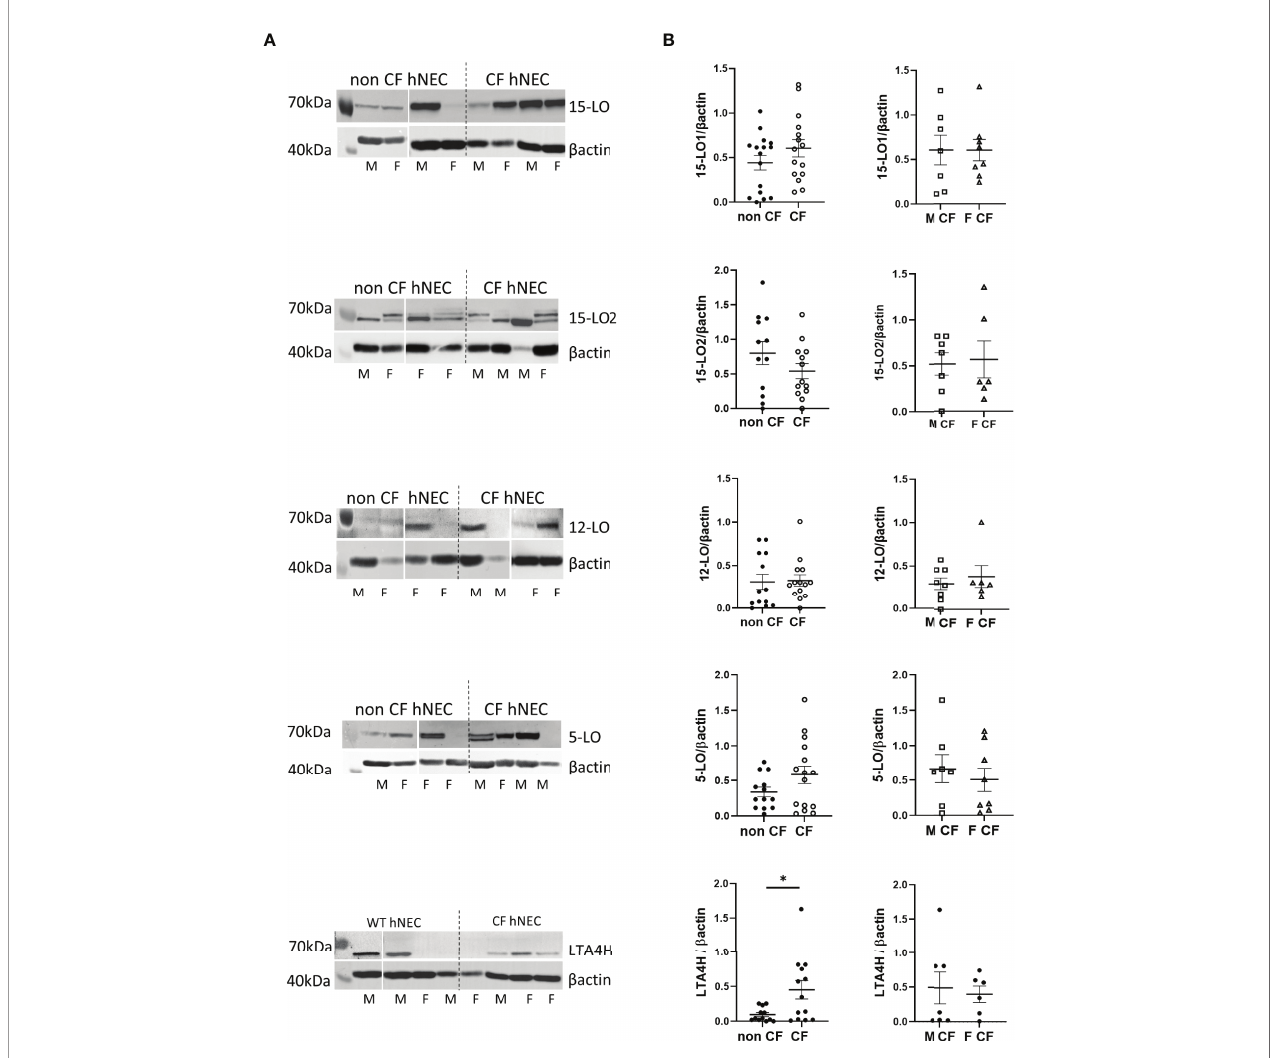
FIGURE 6 | Expression levels of the 15-LO1, 15-LO2, 12-LO, 5-LO and LTA4H in hNEC. (A) Typical western-blotting results from protein extract of non-CF and CF female (F) and male (M) hNEC. (B) Comparison of the mean enzymes expression levels between non-CF and CF hNEC (left) and between CF male and female hNEC (right). *p <